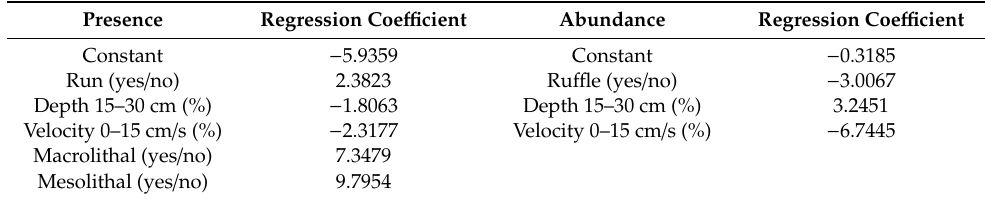
Table 2. Logistic regression-based suitability coe ffi cients for bullhead, derived from Italian mountain streams. The coe ffi cients are multipliers of the attribute values. Positive numbers indicate a positive reaction and vice versa. The receiver operating characteristic (ROC) cuto ff values for the presence and abundance models are 0.435 and 0.42, respectively. The % values for depth and velocity refers to the percentage of measurements in each HMU with values in a given range.